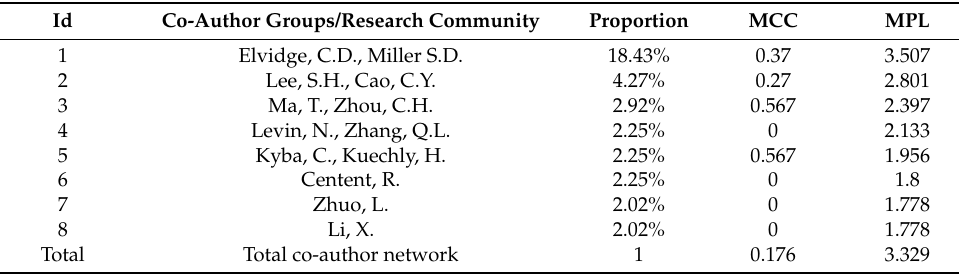
Table 3. Top eight largest research communities in the